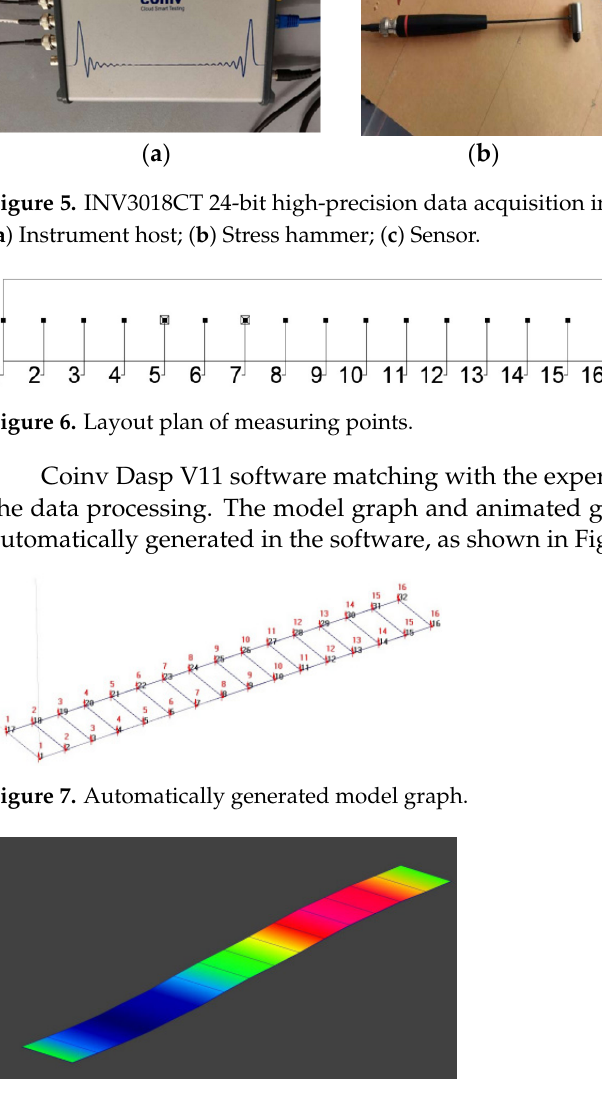
Figure 8. Animated graph of vibration